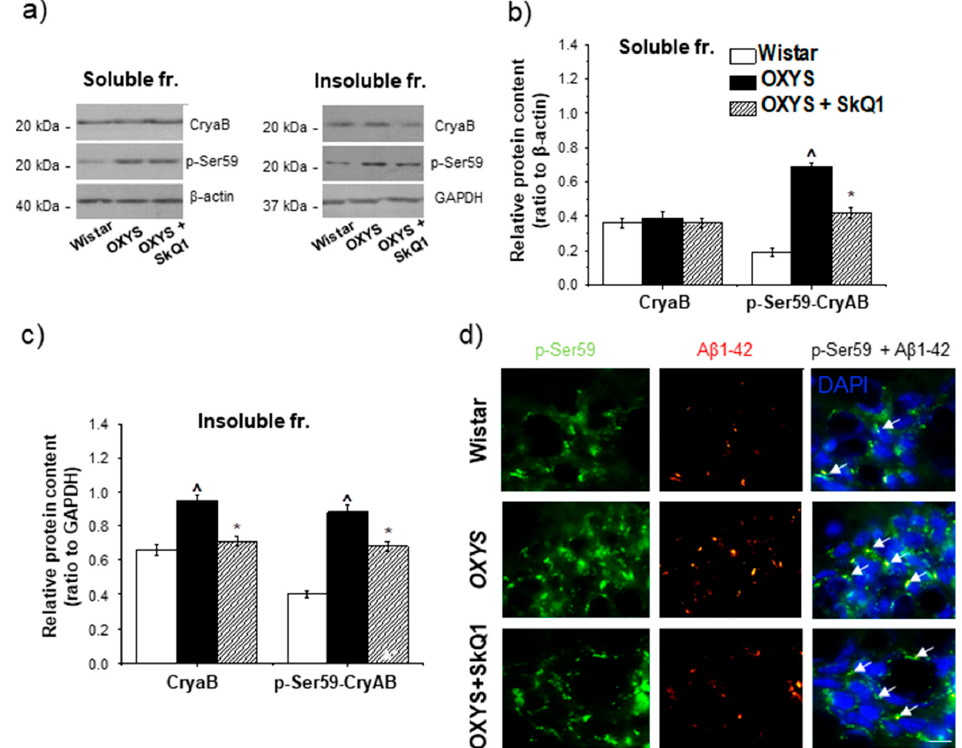
Figure 6. The effect of SkQ1 supplementation in OXYS rats from age 12 to 18 months on the protein levels of CryaB and p-Ser59-CryaB in the hippocampus. Representative western blots of total and phosphorylated CryaB in the detergent-soluble and detergent-insoluble fractions from the hippocampus of untreated Wistar and OXYS rats and OXYS rats treated with SkQ1 ( a ). Graphical presentation illustrates the relative levels of proteins CryaB and p-Ser59-CryaB in the hippocampus of untreated Wistar and OXYS rats and OXYS rats taking SkQ1 after normalization to β -actin for the detergent-soluble protein fraction ( b ) and to GAPDH for the detergent-insoluble fraction ( c ). Data are presented as mean ± SEM of five independent experiments. Immunostaining for p-Ser59-CryaB ( d ) in the hippocampus of untreated Wistar and OXYS rats and OXYS rats taking SkQ1. The nuclei were stained with DAPI (blue). Scale bars, 25 μ m. ^ Statistically significant differences between the strains of the same age; * the effect of supplementation with SkQ1 ( p < 0.05).